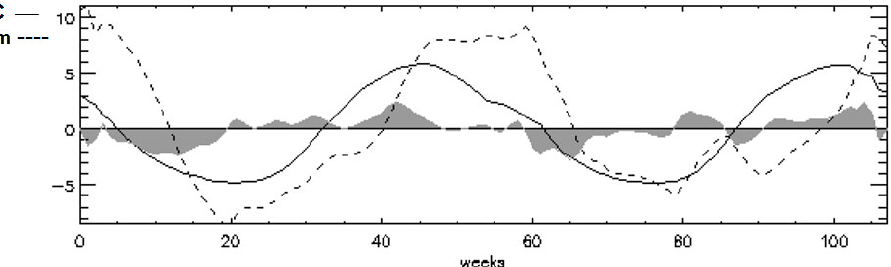
Fig. 11. SST (continuous line) and SLA (dashed line) signal averaged over the basin for the period October 1998–October 2000. The grey-shaded contour represents the time derivative of the SLA, which is proportional to the heating rate of the water